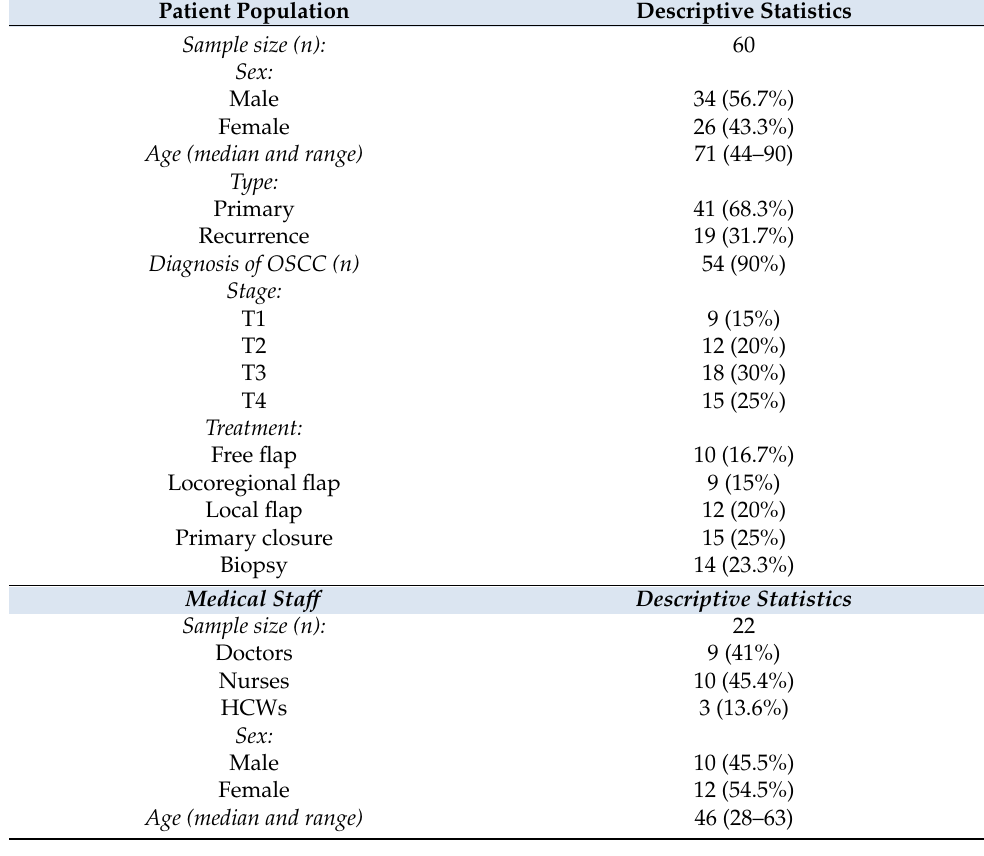
Table 2. Sample characteristics. SD: standard deviation, OSCC: oral squamous cell carcinoma, HCWs: health care workers. Simple descriptive statistics performed by SPSS